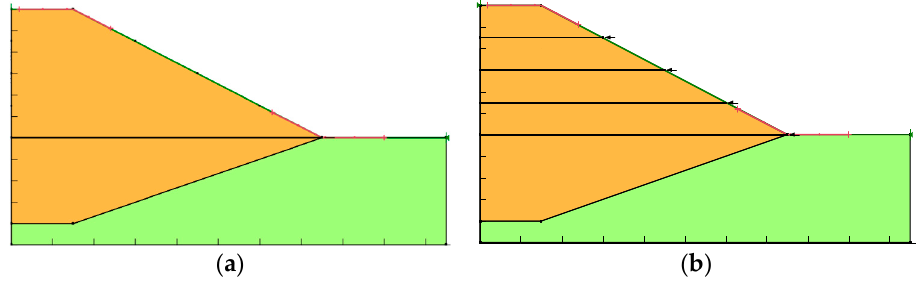
Figure 3. ( a ) Unreinforced; ( b ) reinforced. Slope geometry used in limit equilibrium analysis.